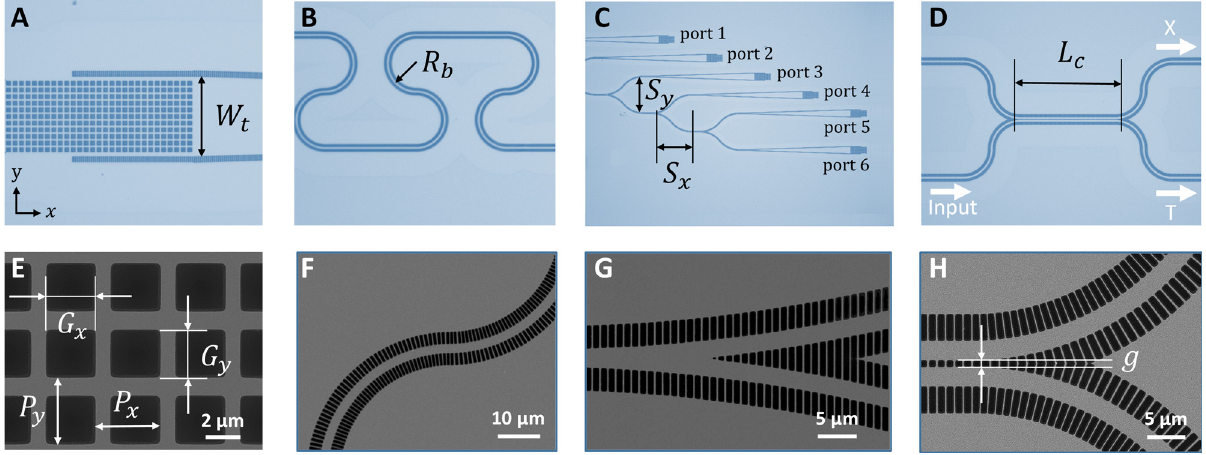
Figure 3: Optical images of (A) Grating coupler; (B) 90 ° bend waveguide; (C) Cascaded Y-junction; and (D) Directional coupler and their corresponding scanning electron microscope (SEM) images (E) –